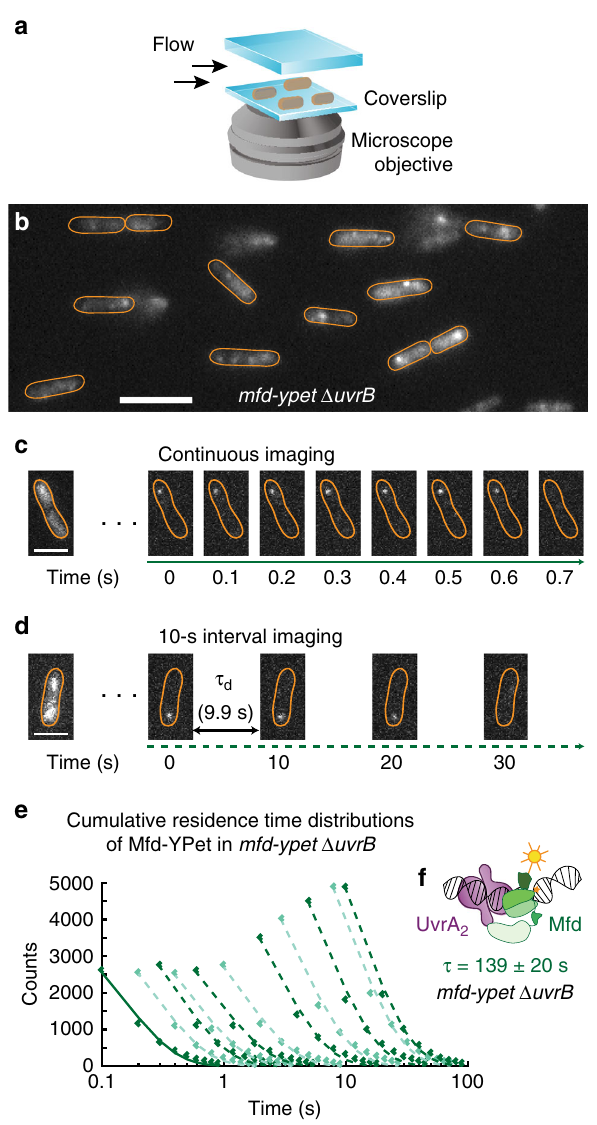
Fig. 2 Measurements of Mfd-YPet binding lifetimes in cells lacking